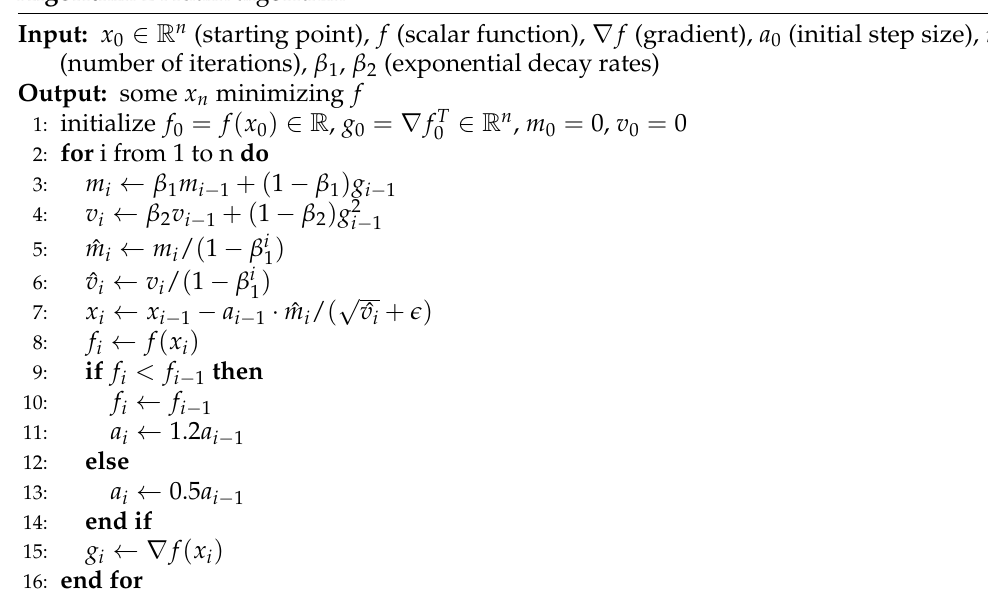
Algorithm 2 Adam